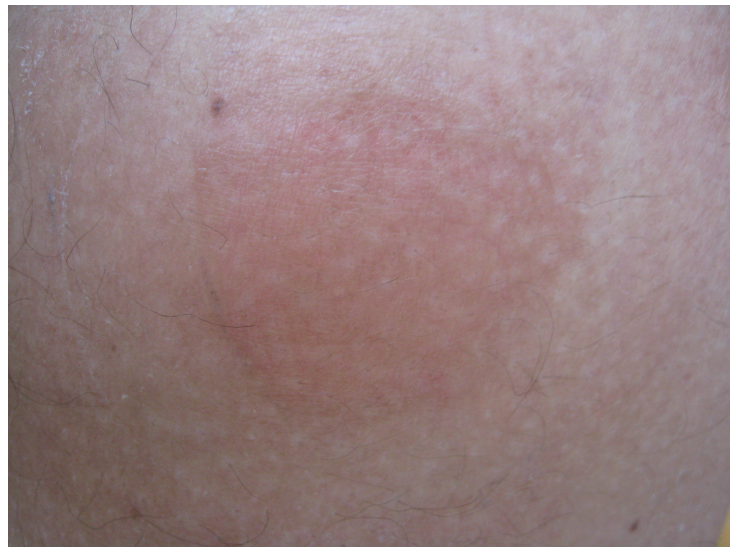
FIGURE 4. Erythema typical of a contact irritative dermatitis reaction secondary to the delivery mechanism of a testosterone